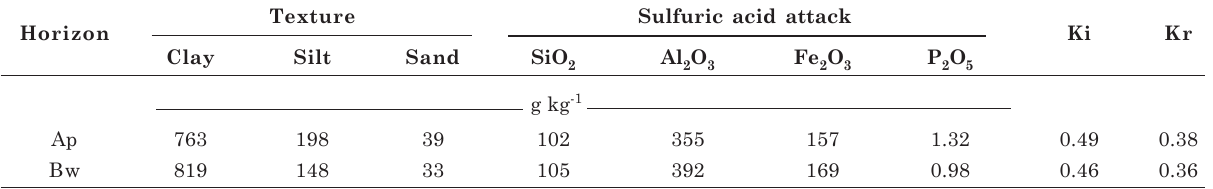
Table 1. Particle size analysis and results of sulfuric acid attack for the Ap and Bw horizons of the